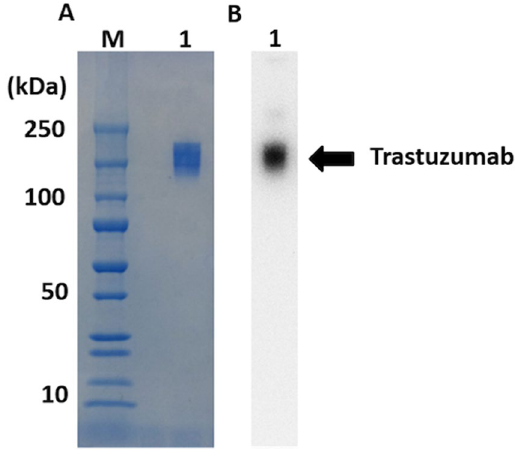
Figure 13. Analysis of [ 125 I] 4 -trastuzumab by SDS-PAGE. Left and right panels show CBB staining ( A ) and autoradiography ( B ), respectively. [ 125 I] 4 -trastuzumab (2.5 ng) was subjected to SDS-PAGE (Lane 1). Lane M shows molecular weight markers. Images were cropped to remove extraneous areas.